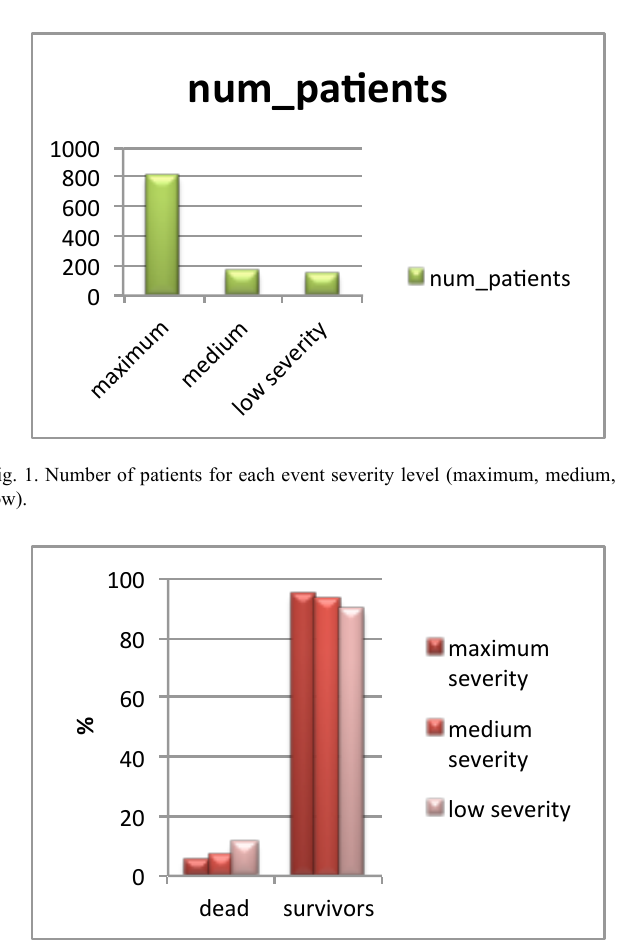
Fig. 2. Percentage of dead and survivors for each event severity level (maximum, medium, low).